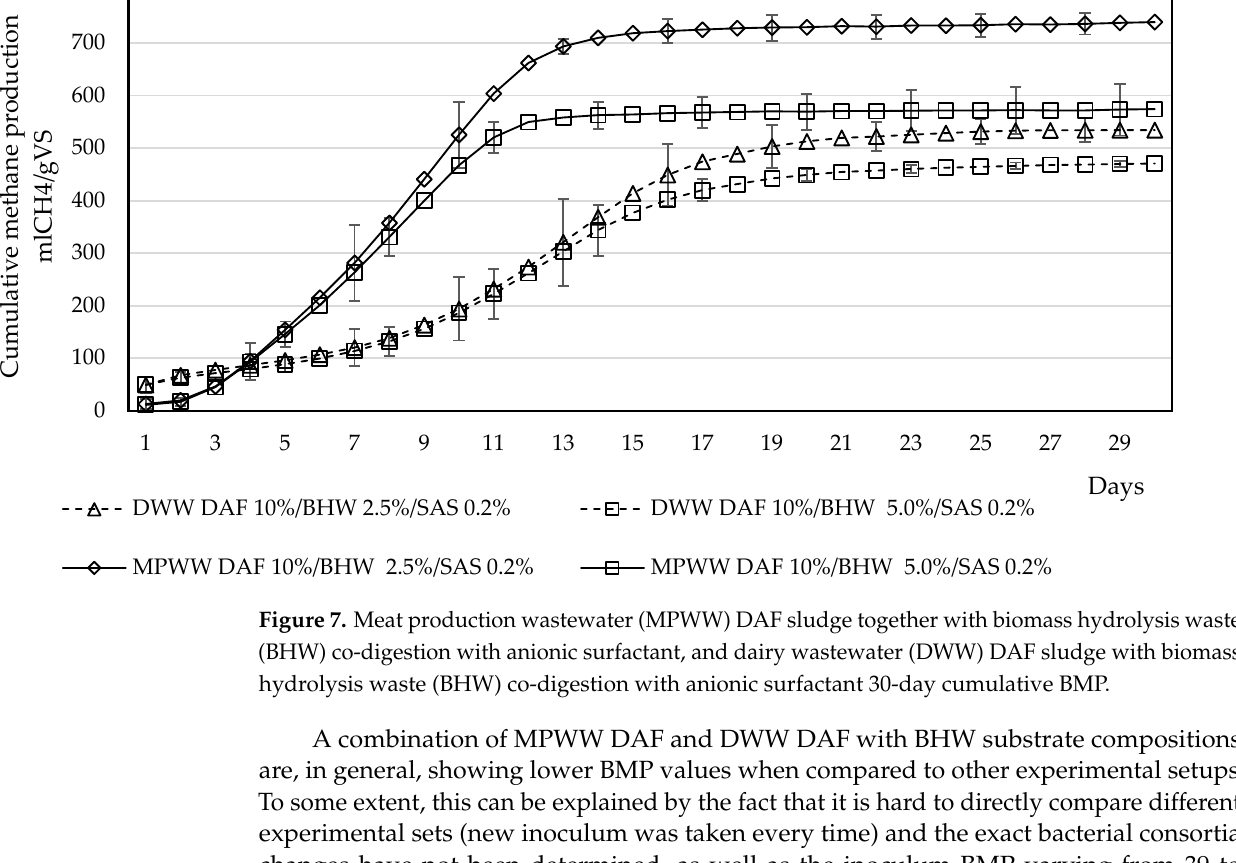
Table 4. Sample BMP potential and biomethane release velocity and inoculum from agricultural biogas station BMP when supplemented with meat production wastewater (MPWW) DAF sludge, together with biomass hydrolysis waste (BHW) co-digestion with anionic surfactant and dairy wastewater (DWW) DAF sludge with BHW.